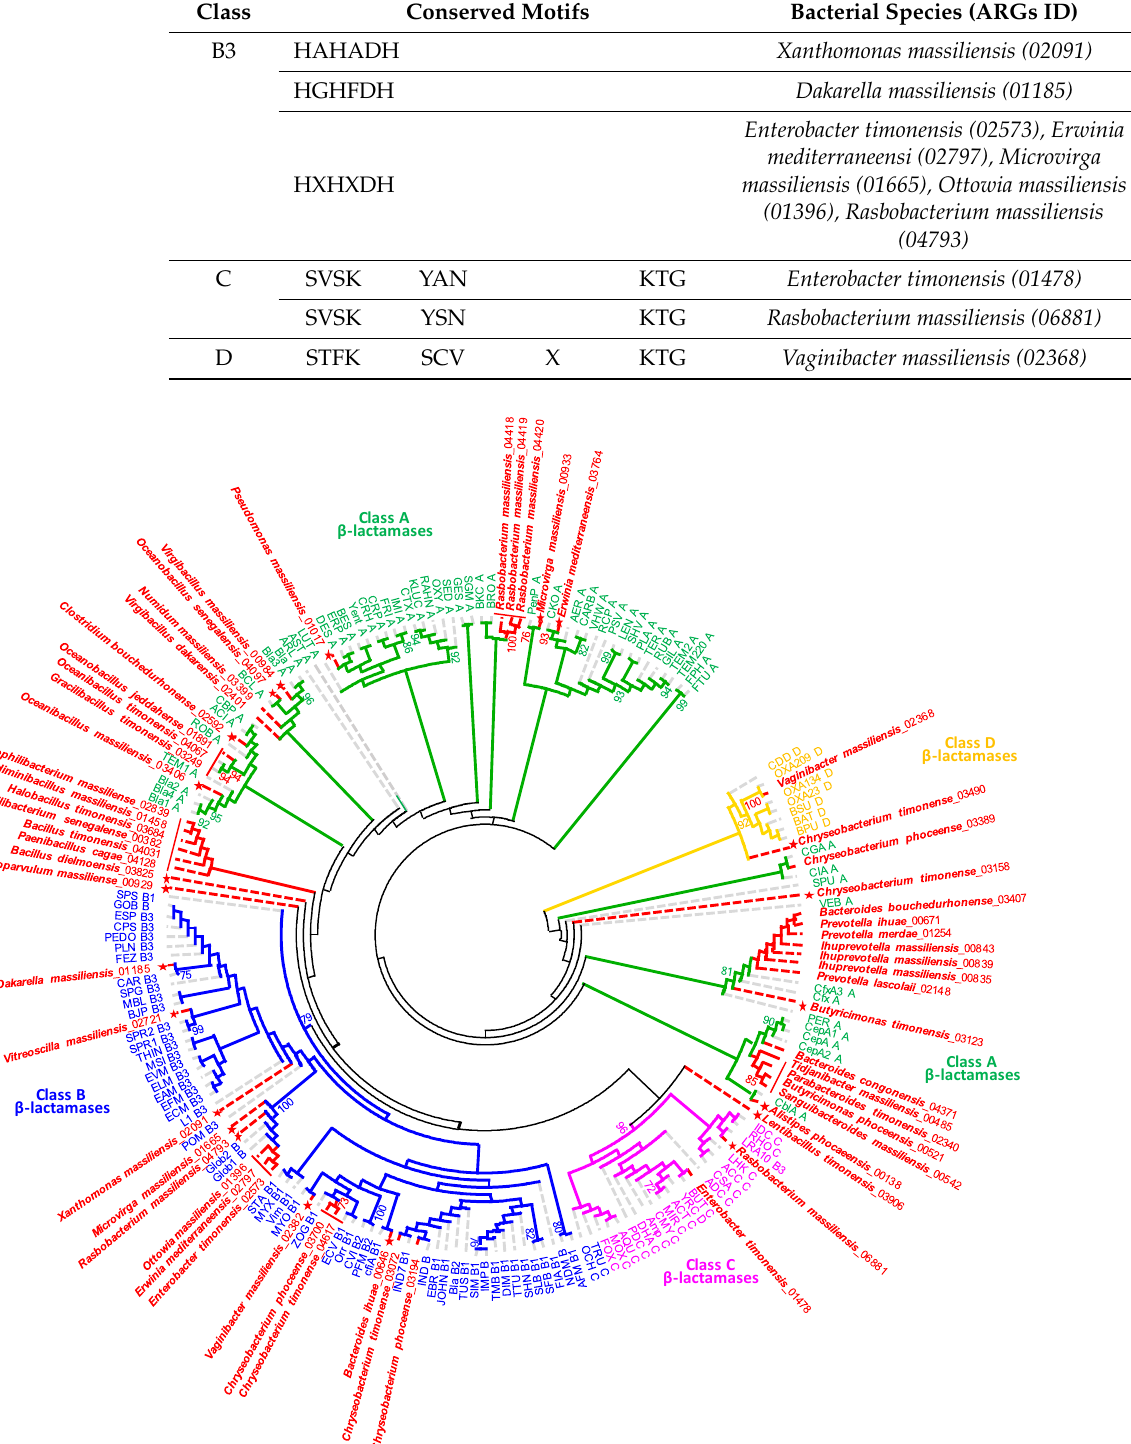
Figure 2. Phylogenetic tree based on β -lactamase sequences. Sequences were aligned based on their amino acid sequences and phylogeny was inferred using the maximum likelihood method. The percentage of trees in which the associated taxa clustered together (100 bootstrap replicates) is shown next to the branches. New ARGs found in the studied species are colored in red, stars indicate a new variant or new ARG-based one and the bars indicate a new family of ARG.